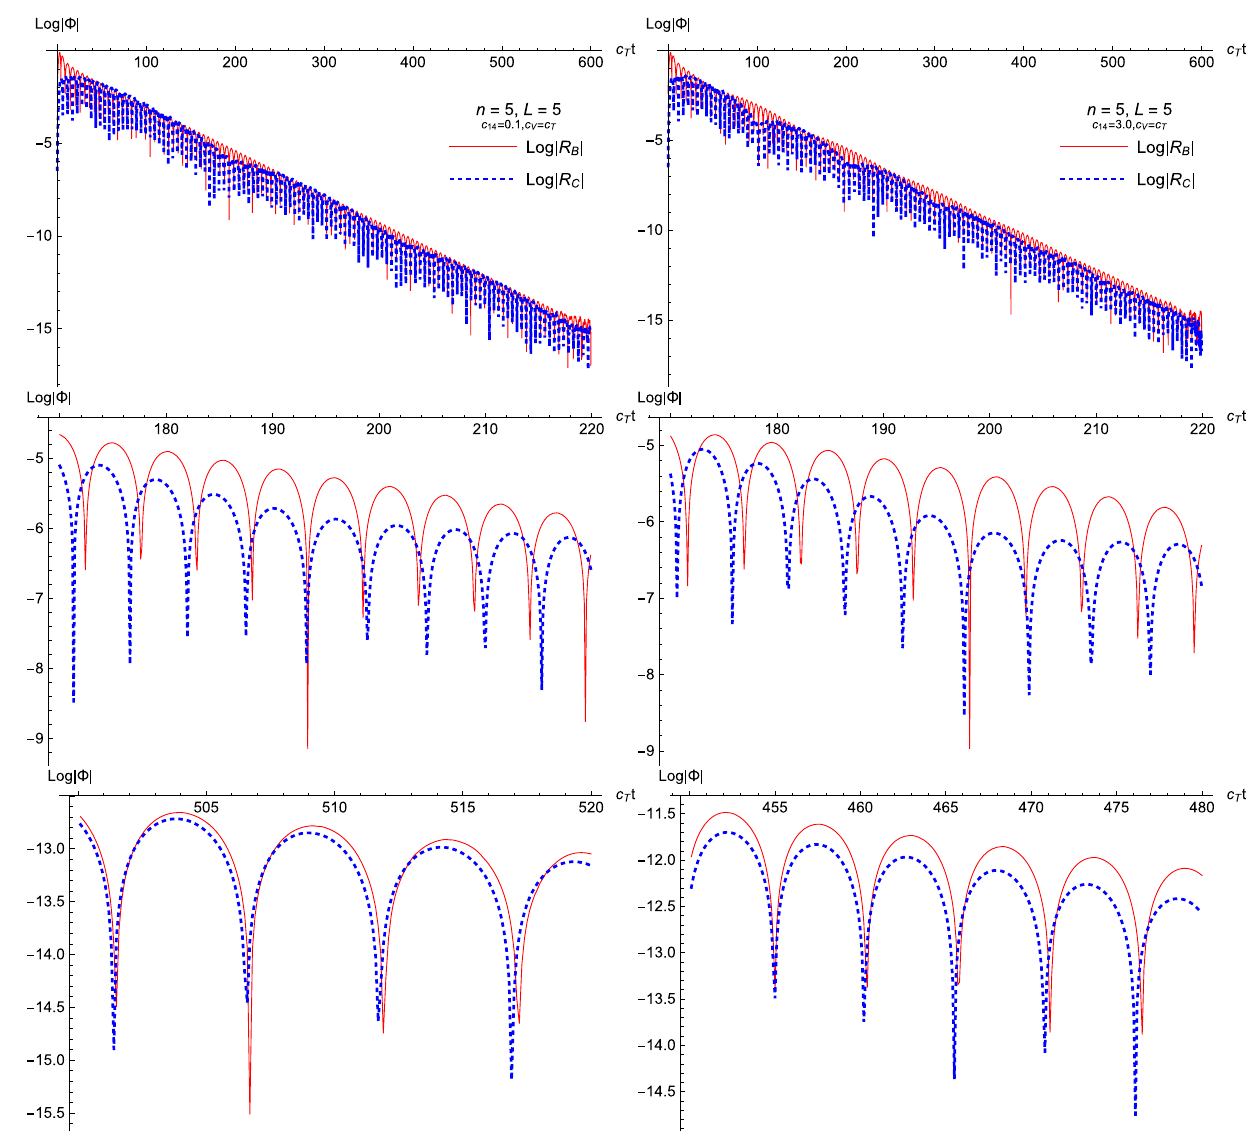
Fig. 5 The time profiles of axial gravitational quasinormal modes for R B and R C for the nonvanishing coupling c 14 (cid:4)= 0. The calcula- tions are carried out using the parameters m = 1, L = n = 5, and c V = c T = 1 /( 1 − c + ) . The top left plot shows the results for a small